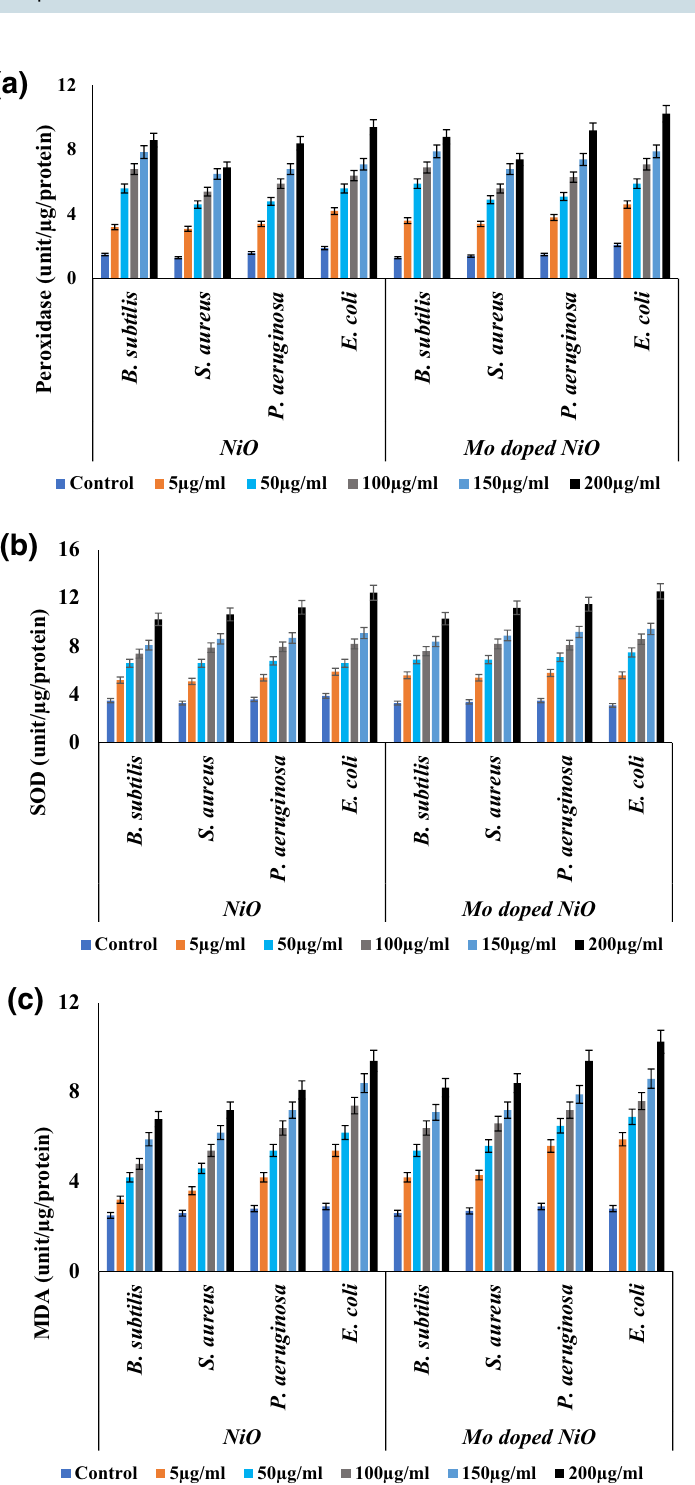
Figure 13. The NiO NPs and Mo doped NiO NPs treatment increased the levels of ( a ) POD, ( b ) SOD, ( c ) MDA assay. Data are presented as mean ± SD. ** p < 0.05, * p < 0.01—statistically significant, ns-not